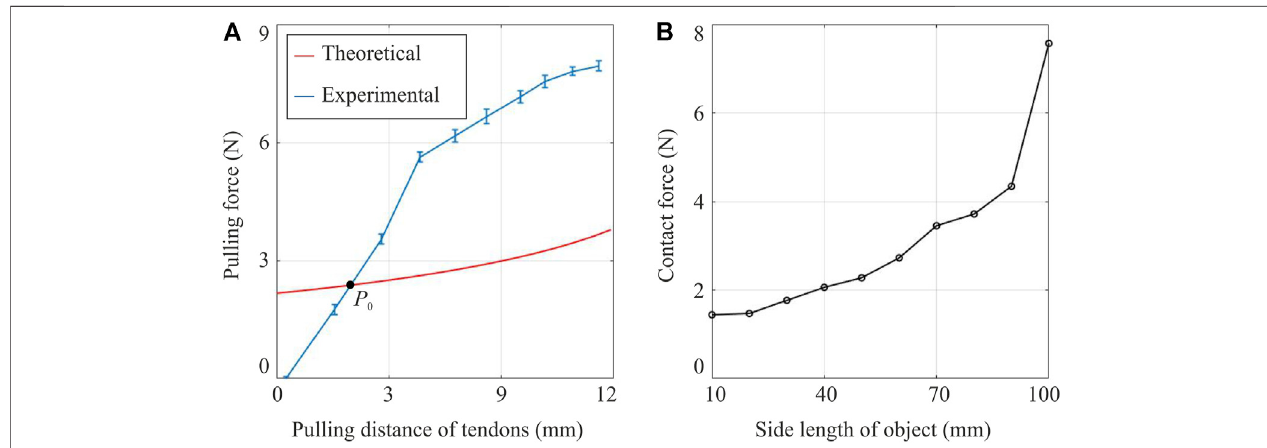
FIGURE 8 | Characterisation results of the gripper ’ s actuation and contact forces. (A) Theoretical and experimental pulling forces on the tendons with error bar vs . the pulling distance. The pulling distance of tendons was converted from the side length of the object that the gripper is able to accommodate. (B) The contact forces generated on objects of different side lengths, ranging from 10 to 100